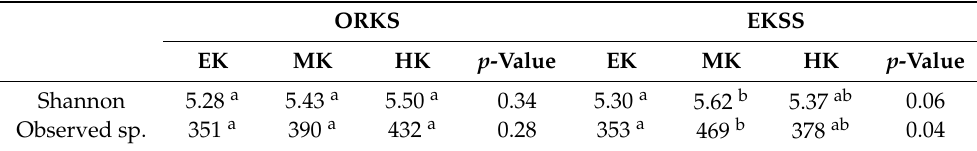
Table 3. Alpha diversity measures Shannon and Observed effects on ORKS compared to EKSS statuses. ORKS EKSS